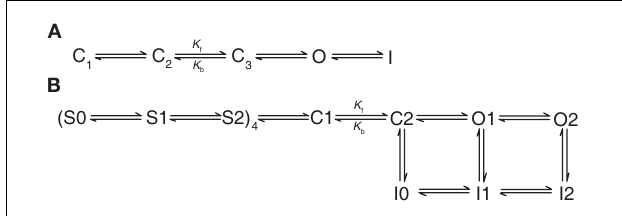
FIGURE 3 | Proposed schemes to describe hERG channel gating. (A) the three closed state model proposed byWang et al. (1997). Kf and Kb represent voltage independent transitions that are rate limiting for opening at strongly depolarized potentials. (B) The modified gating scheme proposed by Piper et al. (2003) to account for the biphasic nature of hERG gating currents and multiple sequential voltage-dependent transitions of the voltage